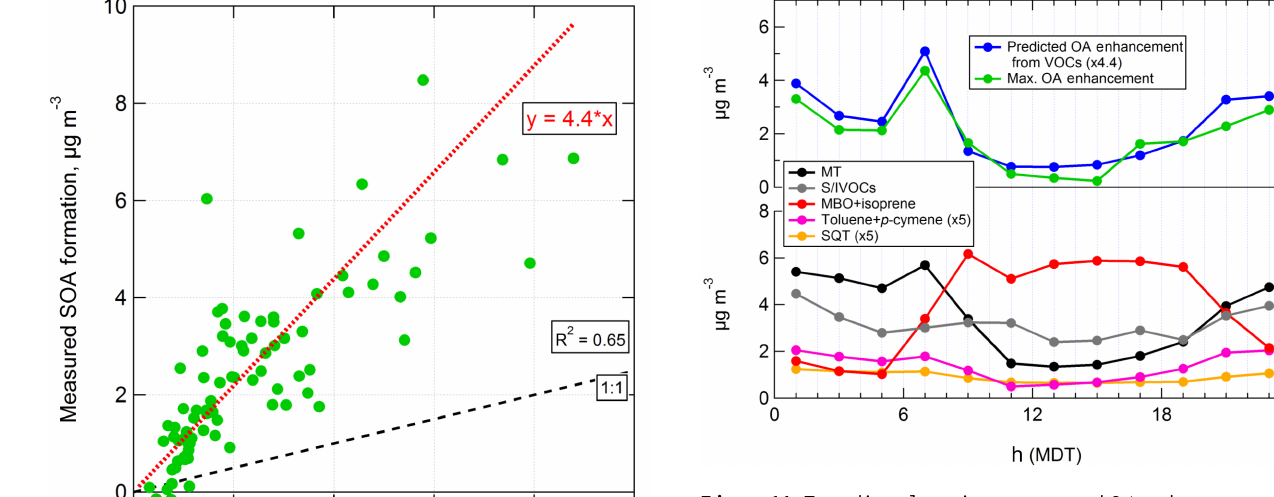
Figure 11. Top: diurnal maximum measured OA enhancement (all data from 0.4 to 1.5 eq. days of aging, LVOC fate corrected) in the OFR from OH oxidation using the OFR185 method, and predicted OA formation from measured VOCs ( × 4.4). Bottom: ambient MT, SQT ( × 5), toluene + p -cymene ( × 5), MBO + isoprene, and S/IVOC mass concentrations vs. time of